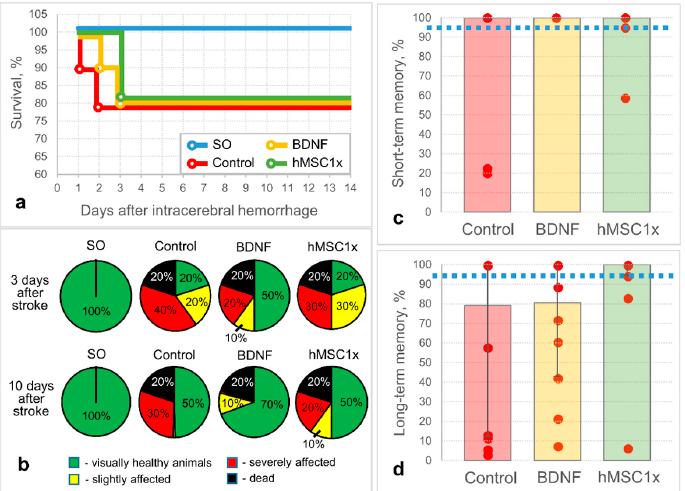
Figure 1. The results of in vivo studies of the neuroprotective activity of the non-concentrated human MSC secretome (hMSC1x): ( a ) survival of the experimental animals; ( b ) neurological status of the experimental animals (SO—sham operated); and the cognitive status of the experimental animals: ( c ) short-term memory (24 h after the intracerebral hemorrhage); ( d ) long-term memory (10 days after the intracerebral hemorrhage). The dashed line corresponds to the memory performance of SO animals. Data is presented as a median (25%; 75%). n = 10; no significant differences between the groups.